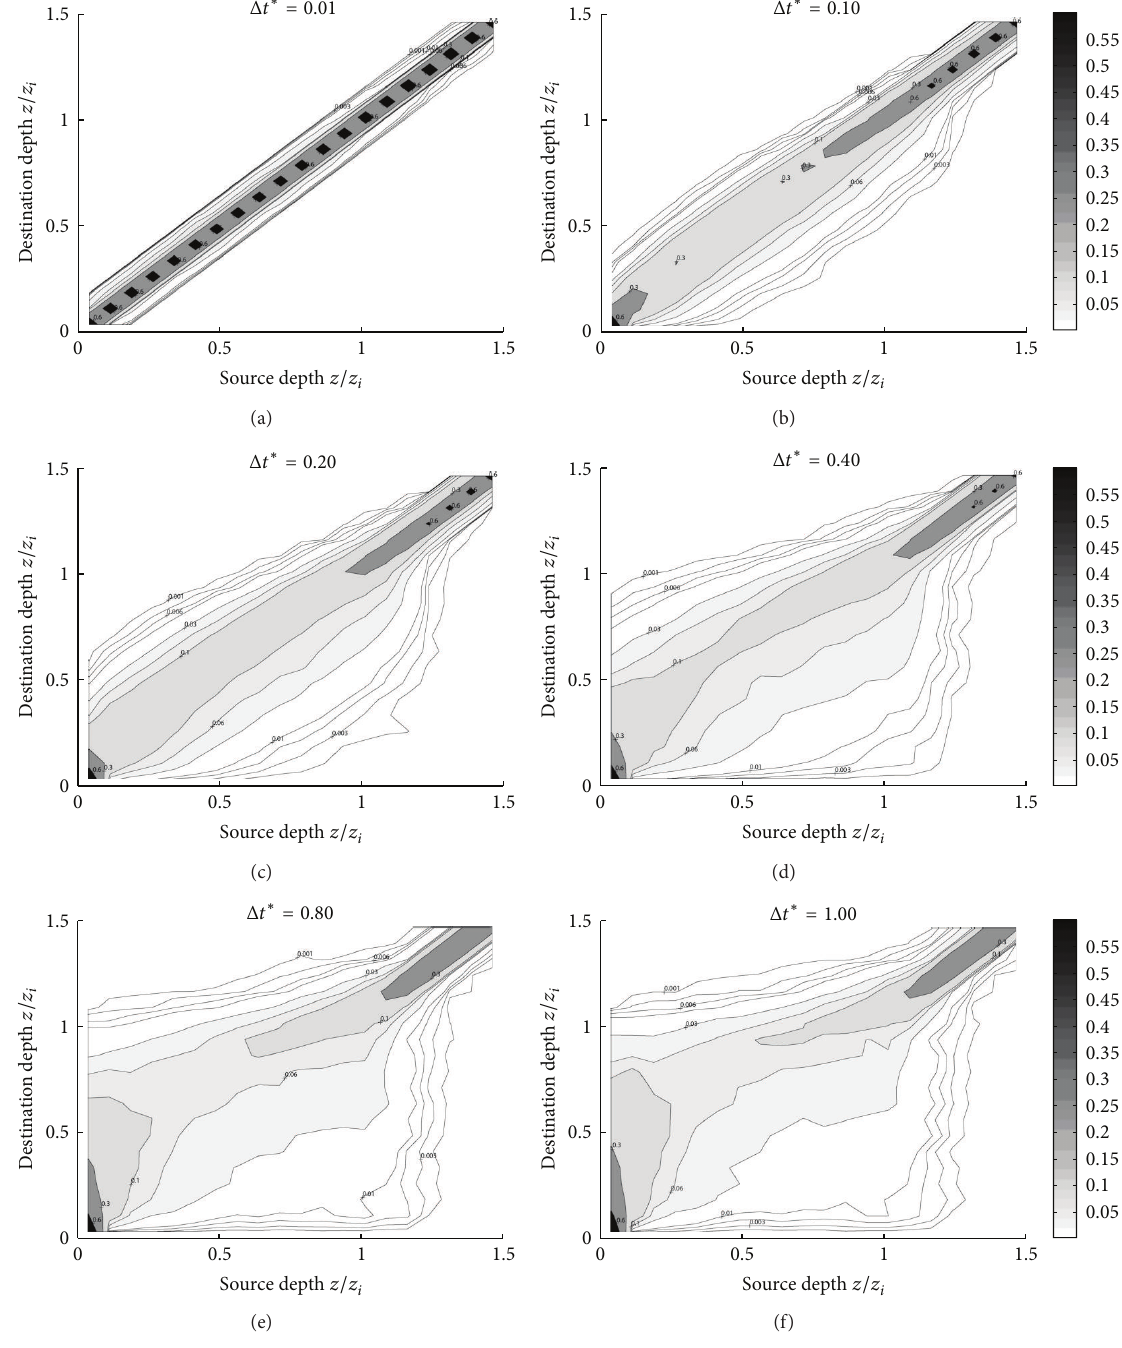
Figure 14: Transilient matrices for various nondimensional time lags (experiment